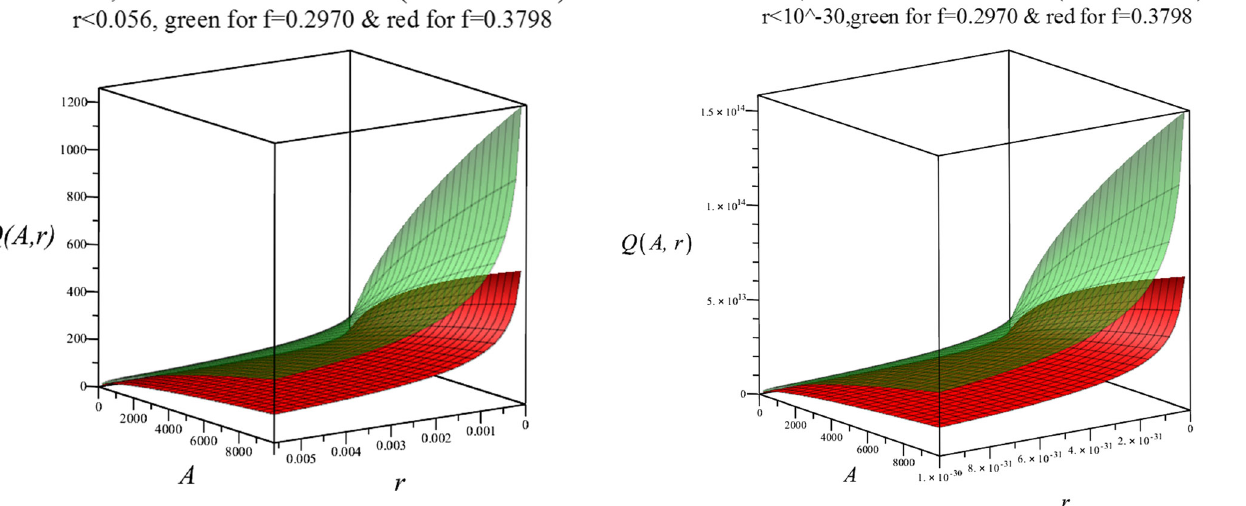
Fig. 6 There is a volume between two colorful surfaces which shows the model in the landscape, compatible with observation and TCC Data Availability Statement This manuscript has no associated data or the data will not be deposited. [Authors’ comment: We have used Planck data which declared in the note and Figs.